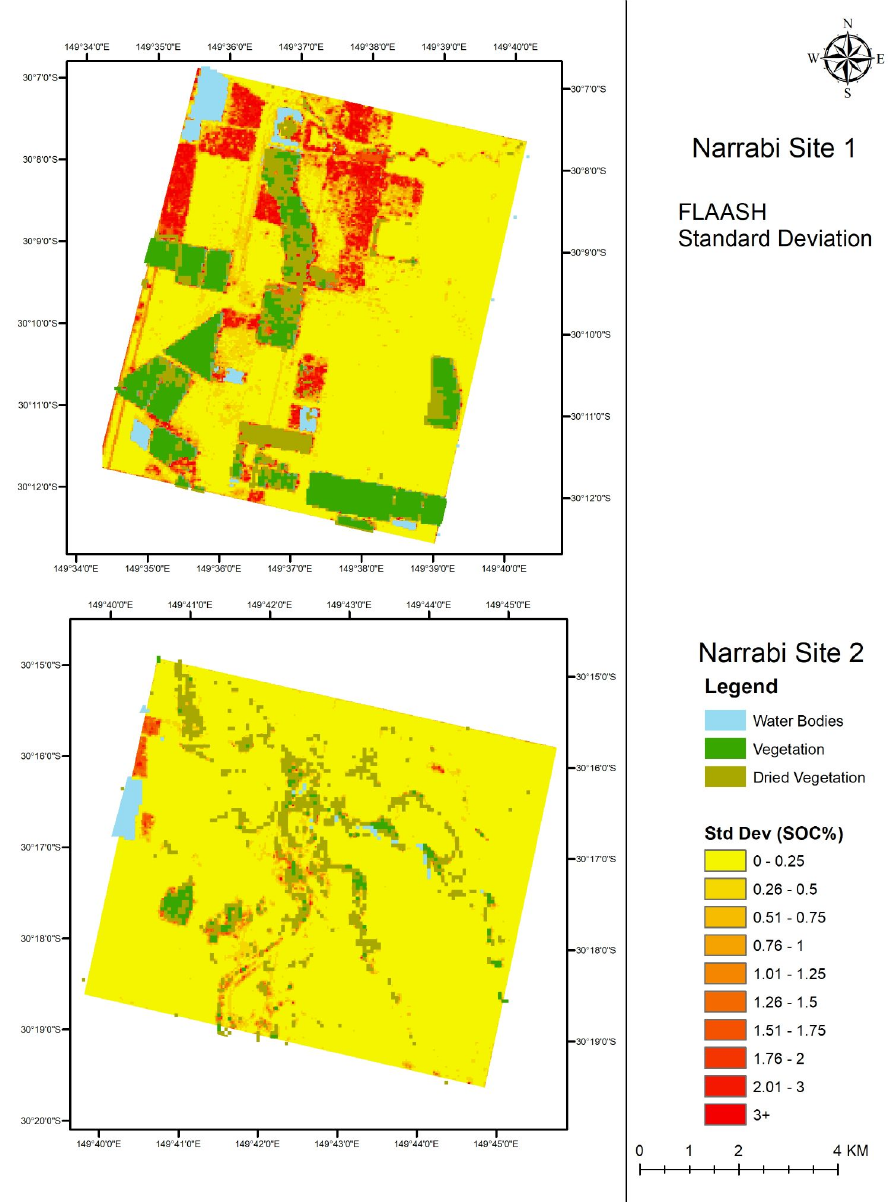
Figure 10. Standard deviation map of estimated SOC obtained along the seven AOD values used with FLAASH method.